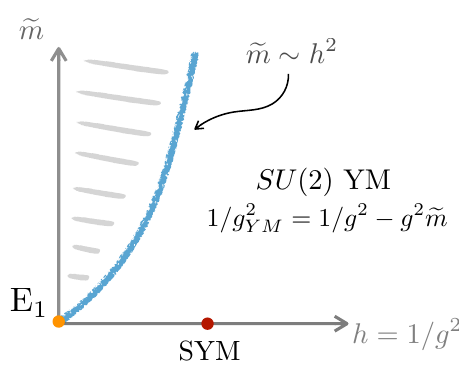
m and h . The white region is e U(1) global symmetry. The I × R U(1) U(1) . Along the blue line a phase I × R → D